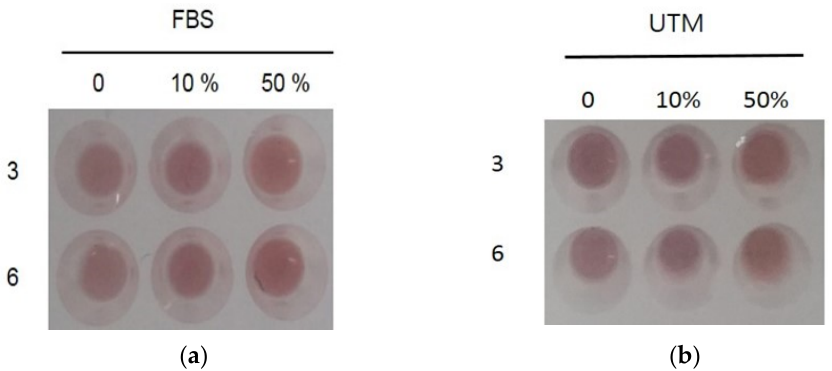
Figure 6. Color images of sialyllactose-levan-conjugated AuNPs with FBS ( a ) and universal transport medium (UTM), a virus culture medium ( b ).